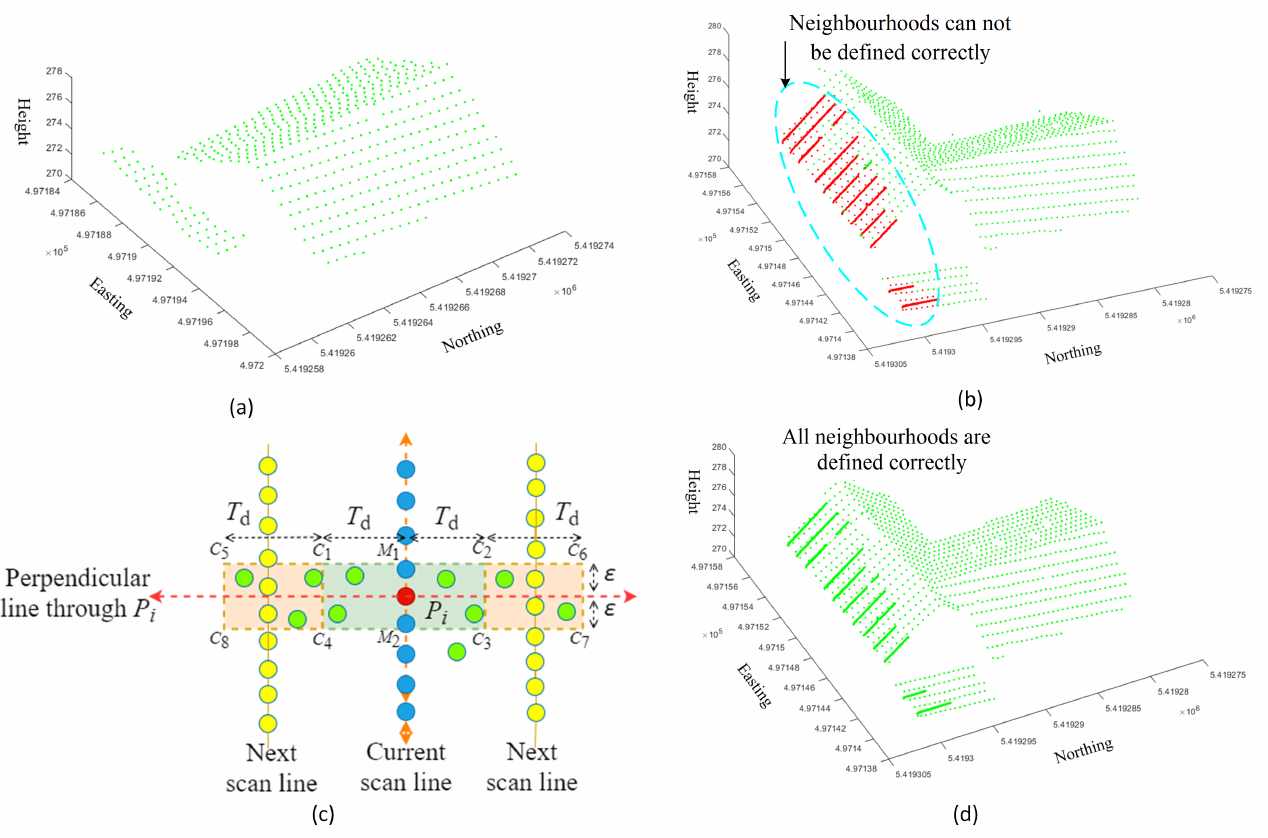
Figure 3. New neighbourhood search across the scanline: ( a ) a successfully defined minimal neighbourhood in a building where points are regularly distributed, ( b ) the red points indicate that minimal neighbourhoods could not be defined, ( c ) a rectangular neighbourhood is iteratively formed, and ( d ) a successfully defined neighbourhood after applying the technique described using ( c